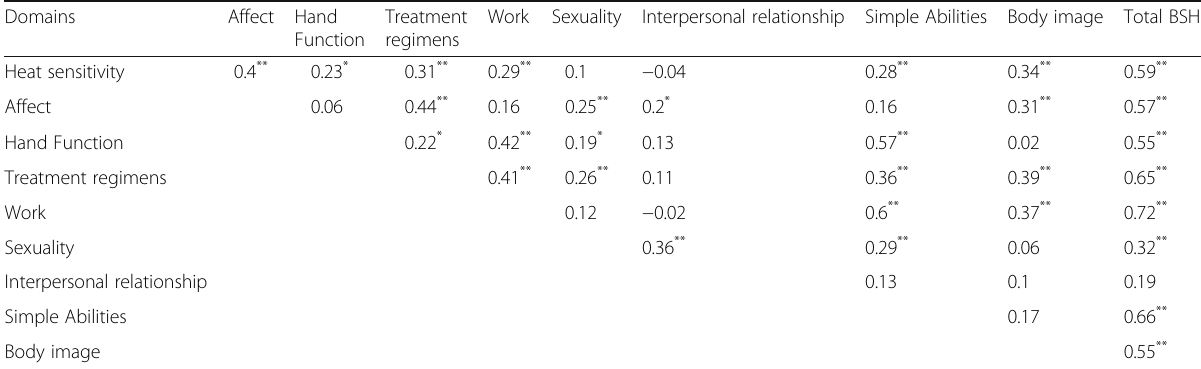
Table 5 Correlation between the domains of BSHS-B-Np Domains Affect Hand